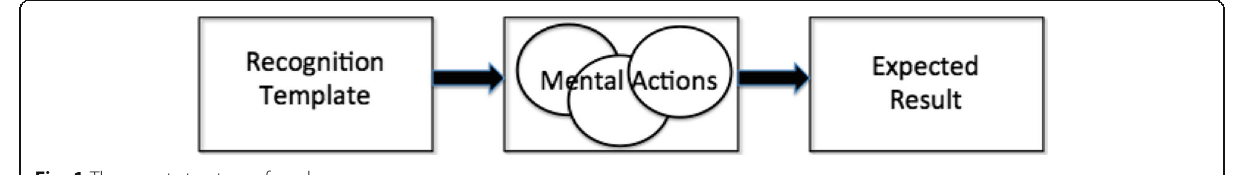
Fig. 1 Three-part structure of a scheme